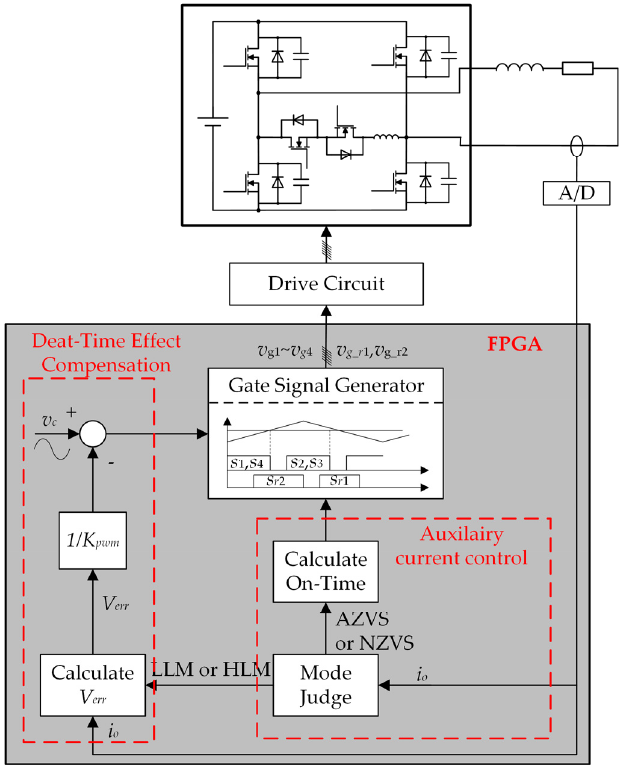
Figure 9. Open ‐ loop control diagram of the ARSI with proposed dead ‐ time effect compensation.